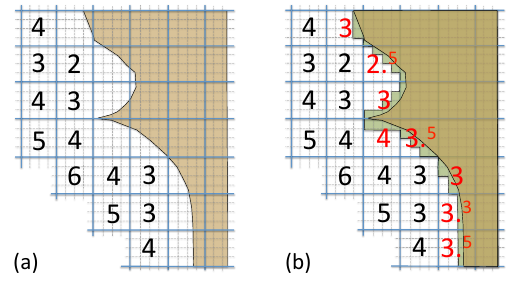
Figure 7. Sea-over-land extrapolation. (a) Numbers represent orig- inal field values, with coastline (black line) and landmass (brown area). (b) Field values after one sea-over-land iteration (replaced missing values are printed as red numbers). Target grid for the in- terpolation performed after application of sea-over-land is drawn as a dashed grid (for ease of presentation, it is drawn exactly 4 times finer than the original grid). Also shown in (b) is the land–sea mask of the target grid (green